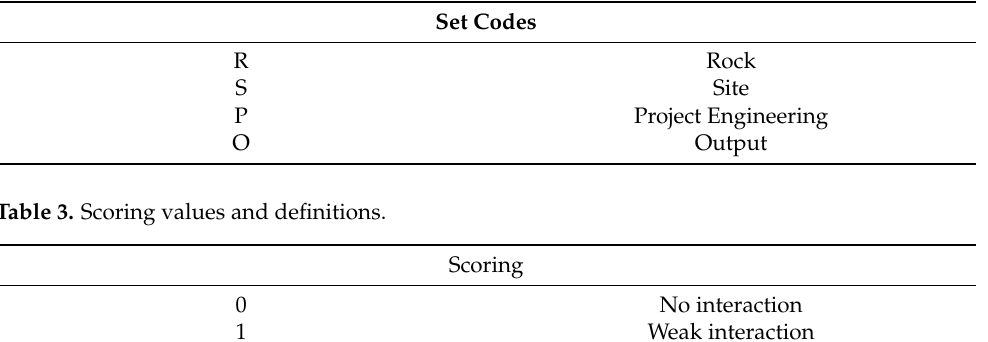
Table 2. Set codes and colour coding.